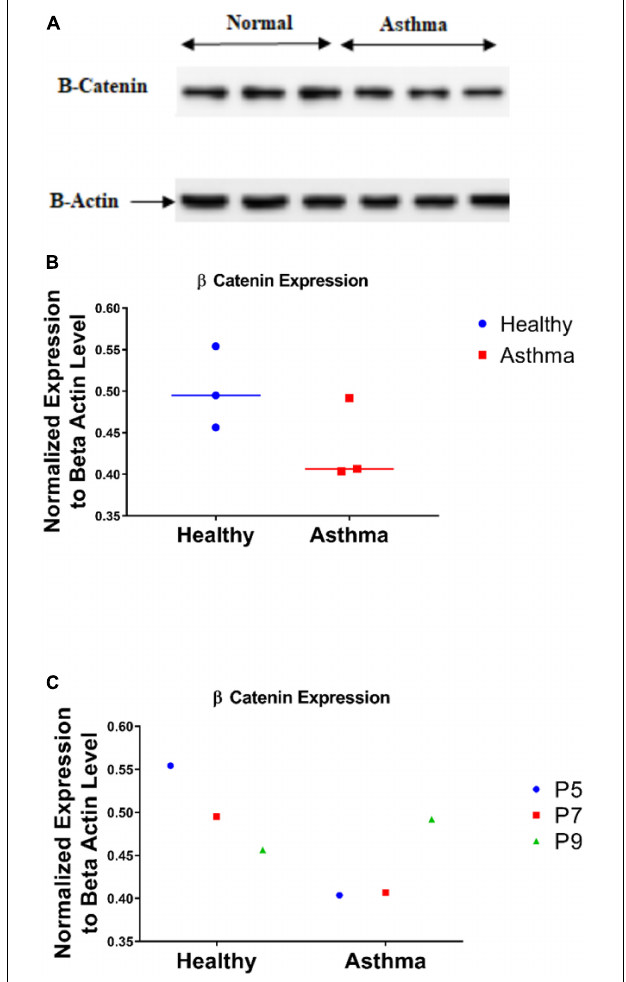
FIGURE 9 | CTNNB1 protein level in bronchial fibroblasts as measured by immunoblot (A,B) in primary fibroblasts from healthy, and asthmatic patients. (C) CTNNB1 protein expression in different passages of each group.